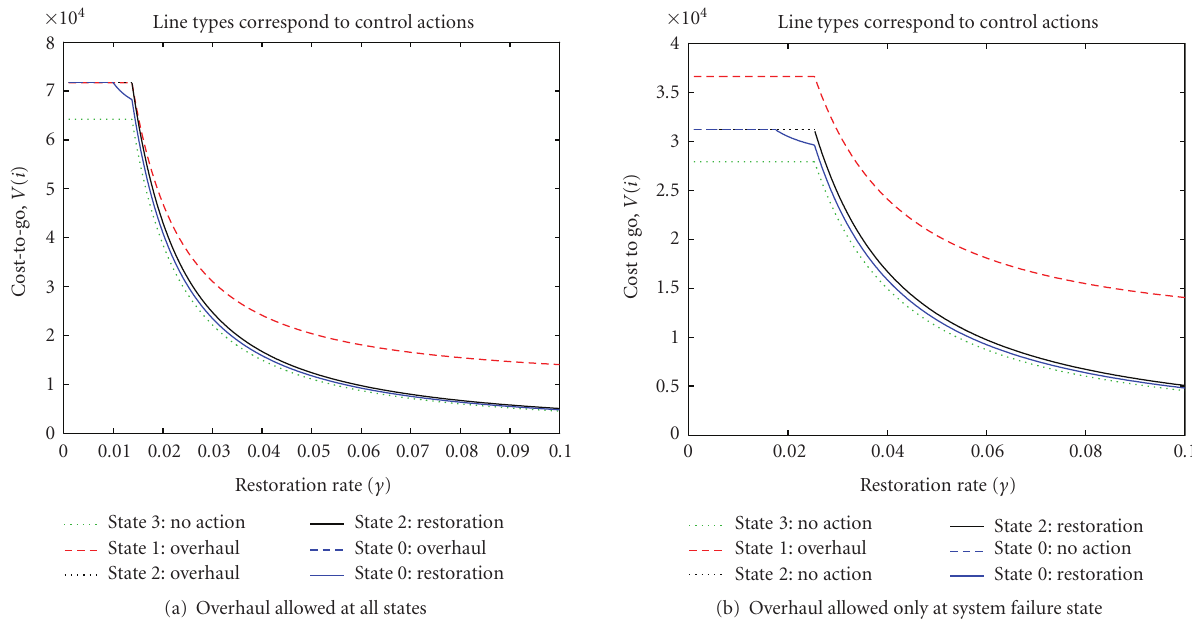
Figure 5: Minimum cost-to-go versus restoration rate for the 4-state model with cost criteria of Table 1.